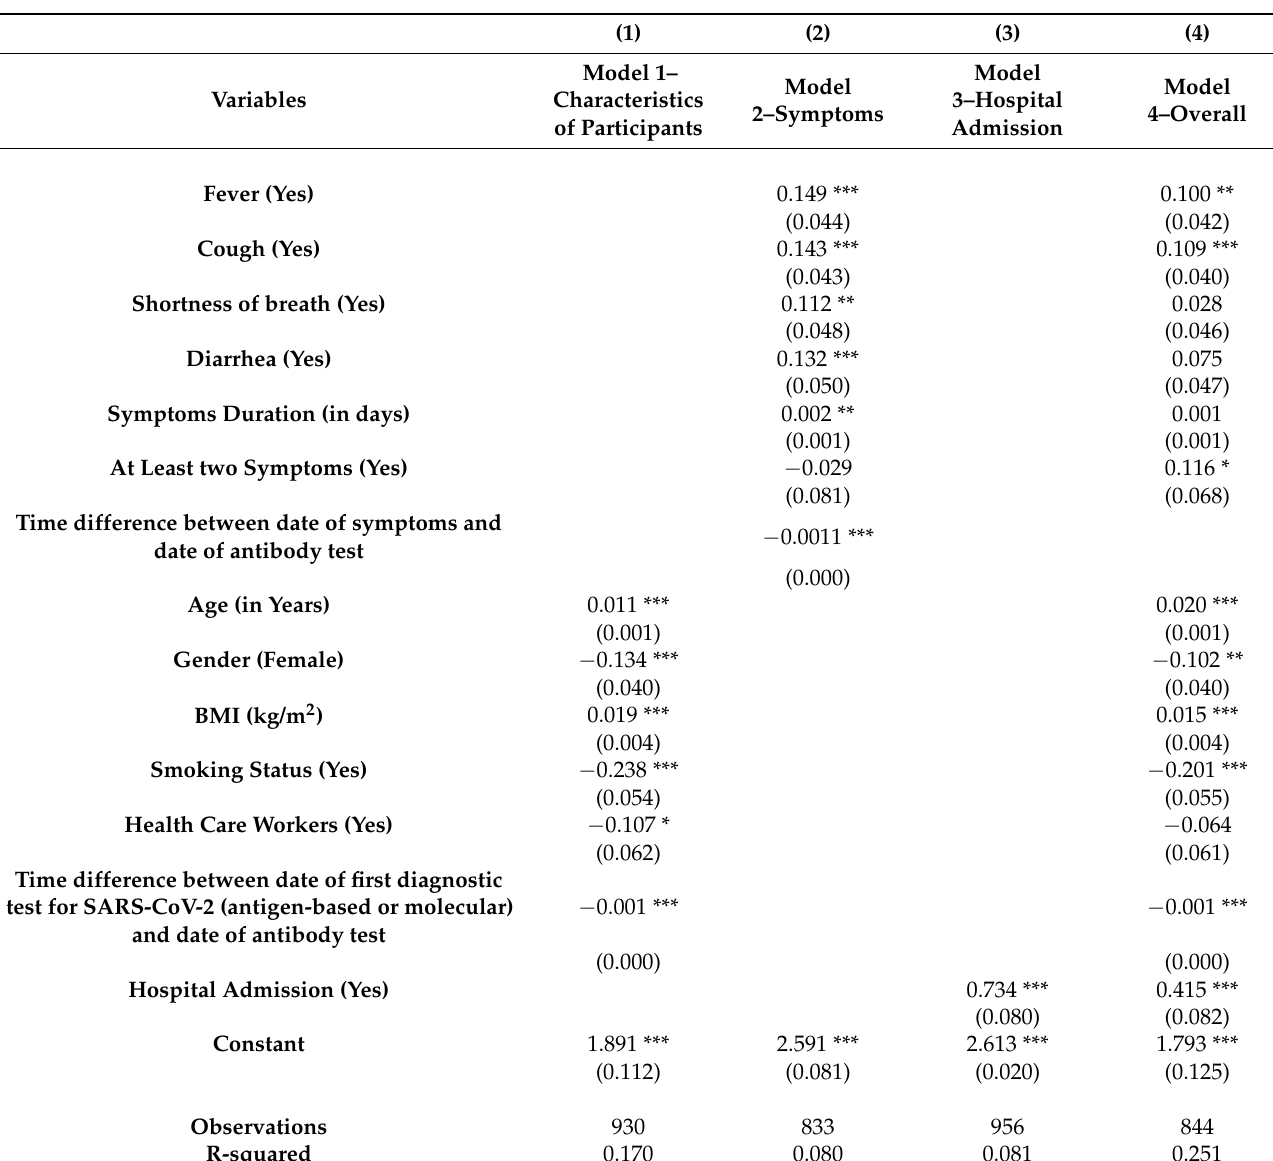
Table 4. Multivariable analyses of levels of anti-SARS-CoV-2 receptor binding domain-specific immunoglobulin class G (IgG) antibodies (logarithm base 10-transformed) against various factors and covariates. The analysis involved 909 unvaccinated individuals with a reported history of SARS-CoV-2